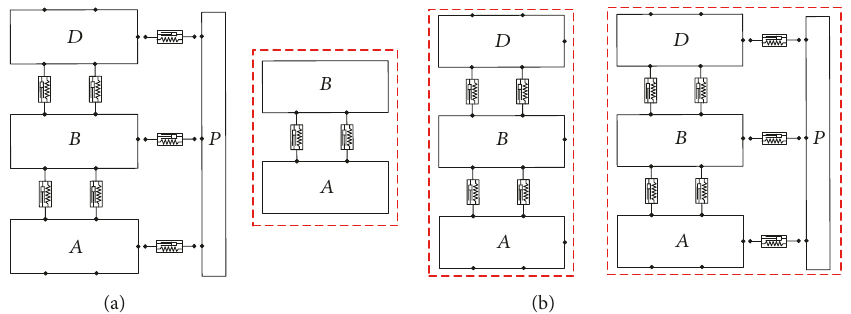
Figure 2: (a) Sketch of the FRF coupling of the synthesis; (b) synthesizing